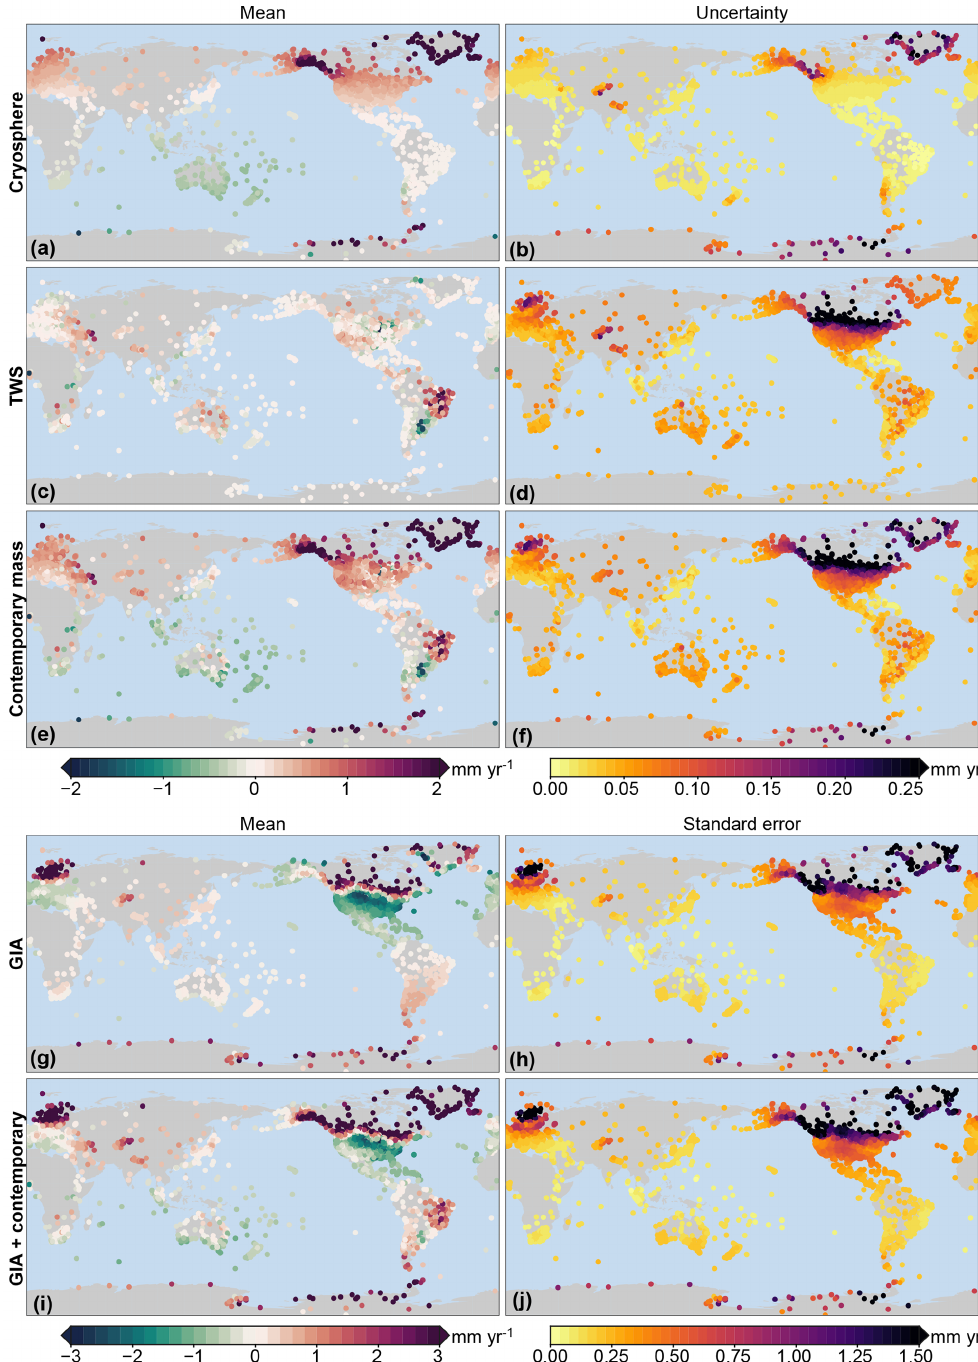
Figure 11. The modeled linear trends due to SED computed over the time span of the individual GNSS record. The left panels show the mean trend, and the right panels show the uncertainty from the large ensemble. Note that the color scales for the top three rows differ from the color scales of the bottom two